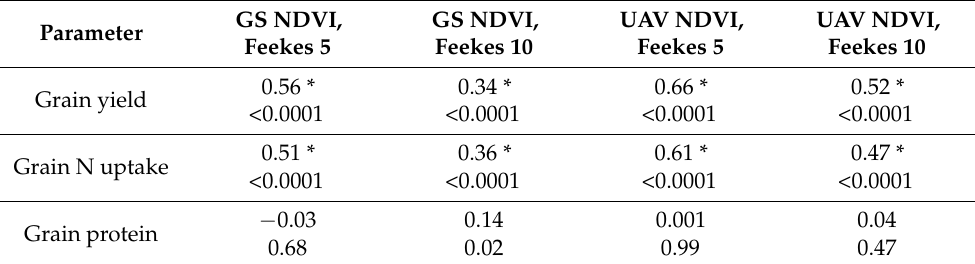
Table 1. Pearson correlation coefficients and probability > |r| for spring wheat grain yield, grain N uptake, and grain protein content with GS NDVI and UAV NDVI at Feekes 5 and Feekes 10 for 14